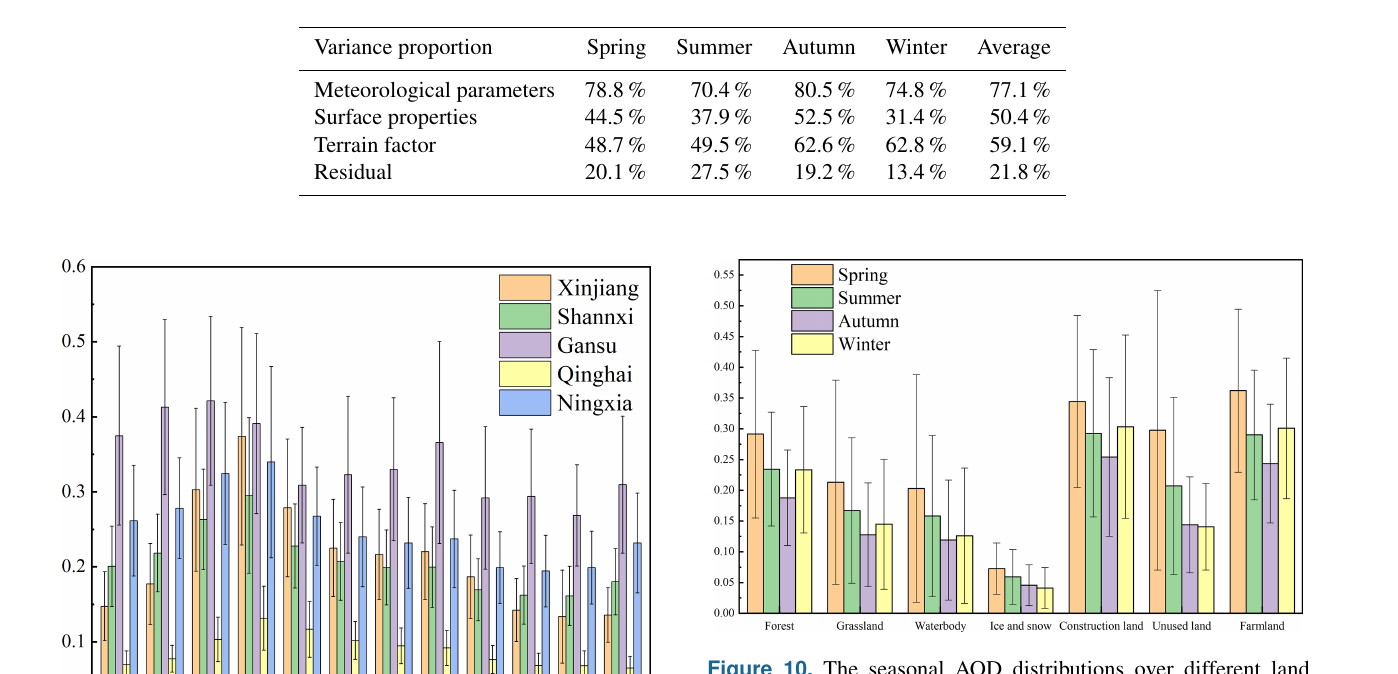
Figure 8. Temporal information entropy (TIE) and time-series information entropy (TSIE) of the AOD distribution. Table 2. Three groups of environmental covariates for AOD variation partitioning.